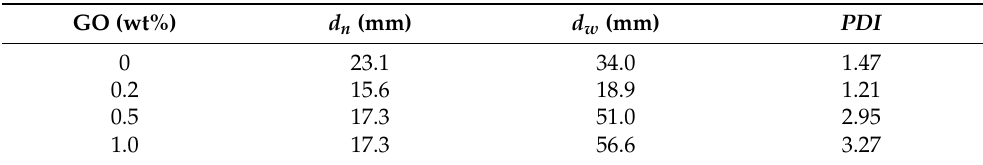
Table 4. Average diameters and PDIs of dispersed asphalt domains in the unmodified and GO-modified EABCs.